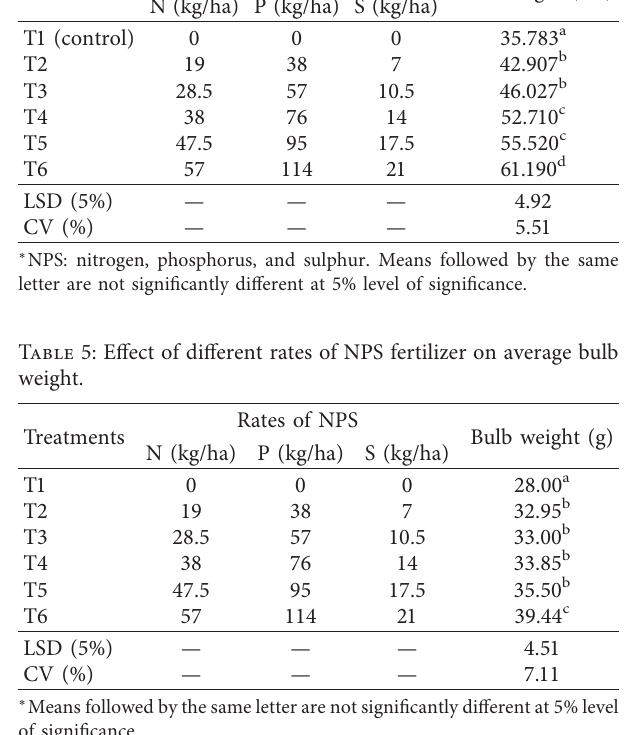
Table 4: Effect of different rates of NPS fertilizer on the plant height of garlic.